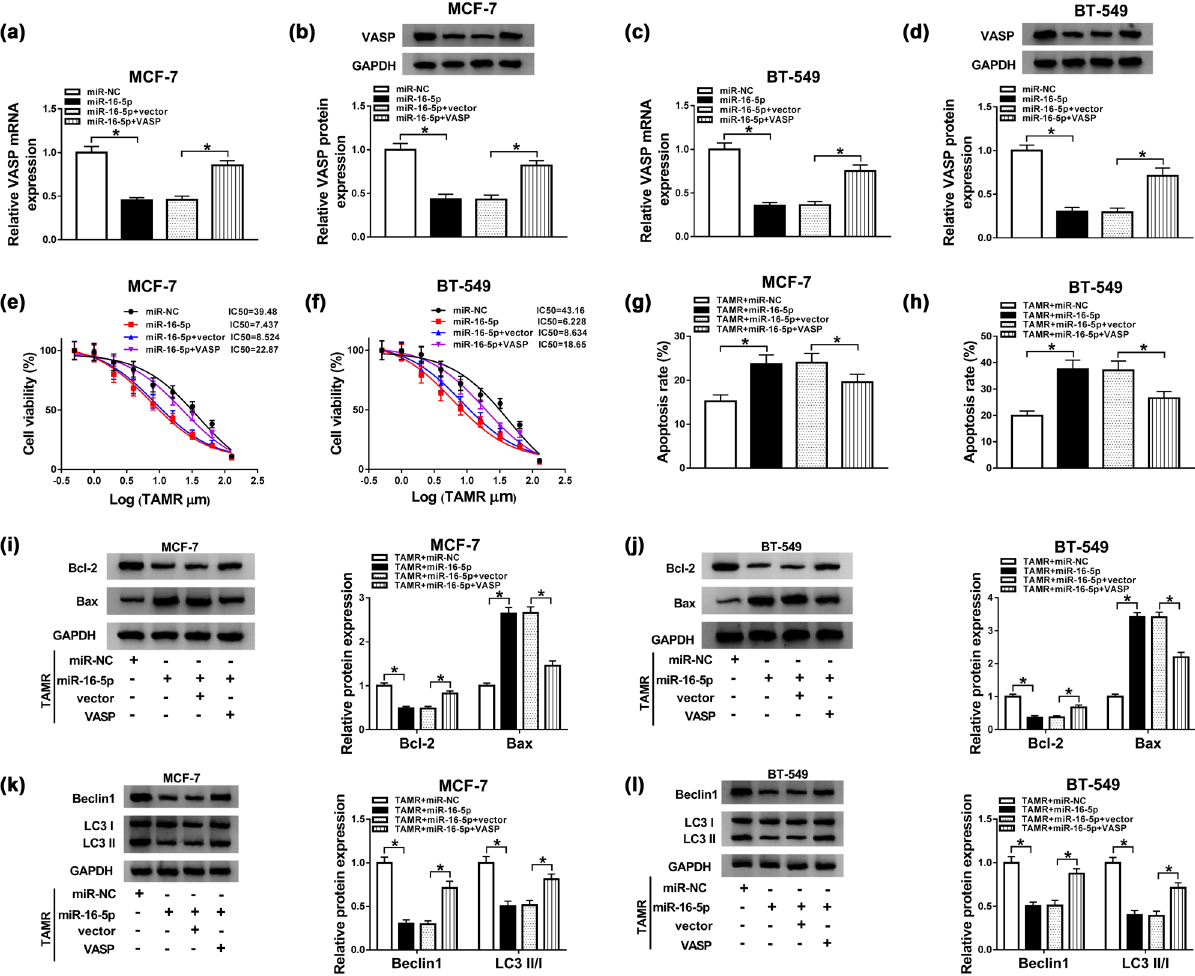
Figure 6: The overexpression of miR - 16 - 5p promoted TAMR sensitivity by VASP. MCF - 7 and BT - 549 cells were transfected with miR - NC mimic, miR - 16 - 5p mimic, miR - 16 - 5p mimic + vector, or miR - 16 - 5p mimic + VASP ( VASP overexpression plasmid ) before TAMR treatment with the indicated concentrations, followed by the determination of VASP mRNA and protein levels ( a – d ) , the IC 50 value for TAMR by MTT assay ( e and f ) , cell apoptosis by fl ow cytometry ( g and h ) , Bcl - 2 and Bax levels by western blot ( i and j ) , and the levels of Beclin 1, LC3 I and LC3 II by western blot ( k and l ) . * P <